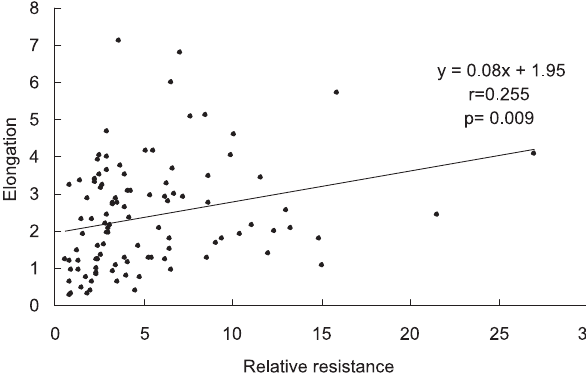
Figure 4 - Correlation between elongation and relative resistance (resistance relative to